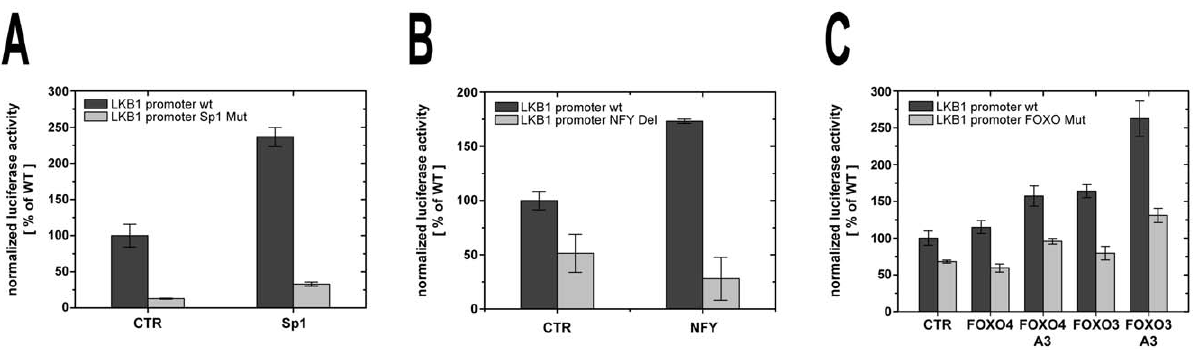
Figure 7. NF-Y, Sp1 and FOXO transcription factors activate transcription from the LKB1 promoter. Luciferase reporter assays in C33a cells after over-expression of Sp1 ( A ), NF-Y ( B ) and FOXO transcription factors ( C ). Reporter activity of LKB1 wild-type promoter is indicated in dark grey, while reporter activity of constructs lacking the corresponding transcription factor binding site is indicated in light grey. Luciferase activity (relative light units normalized to renilla luciferase activity) is expressed as the percentage of the signal obtained from co-transfection of 100 ng of the plasmid containing the LKB1 wild-type promoter (LKB1 Pro II, 2 549 to + 727) together with 150 ng of the empty expression vector (CTR). Instead of the empty vector 150 ng of the corresponding transcription factor expression plasmid have been co-transfected. In the case of NF-Y 50 ng of plasmids encoding each subunit NF-Y a , NFY- b and NF-Y c were transfected together. Each bar represents the means 6 standard deviation of three independent